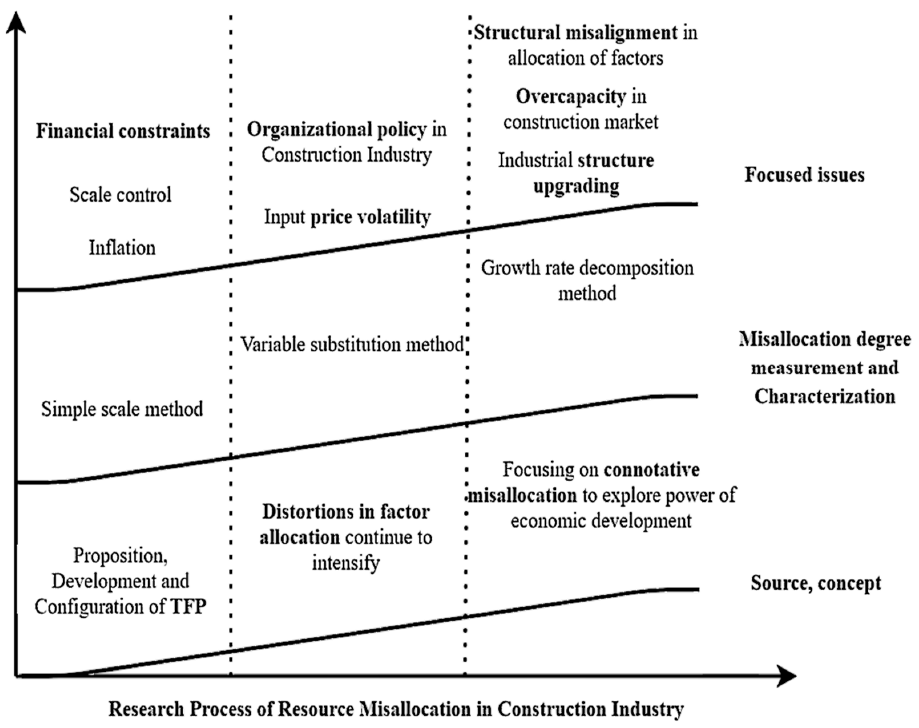
Figure 9. Dimensional model of resource misallocation.